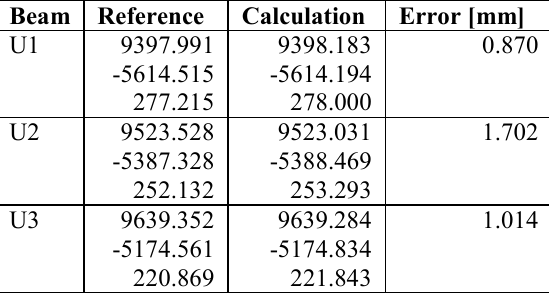
Table 1 . Coordinates (in mm) of the U-Beams